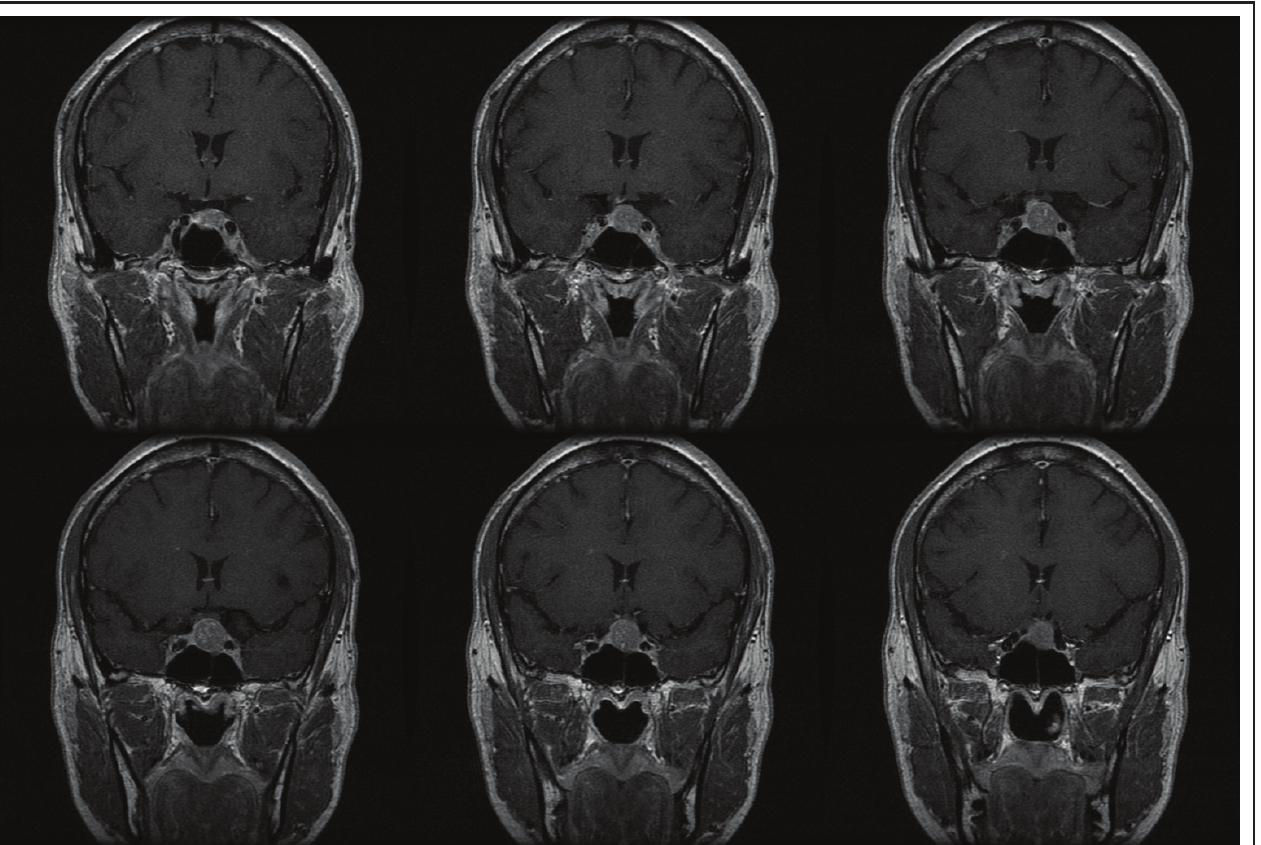
FIGURE 1: Non-functioning pituitary macroadenoma in a 46-year-old male.